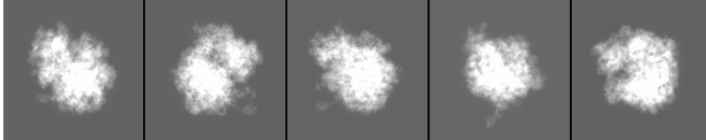
Figure 2. Simulated E. coli ribosome cryo-EM SPM particle